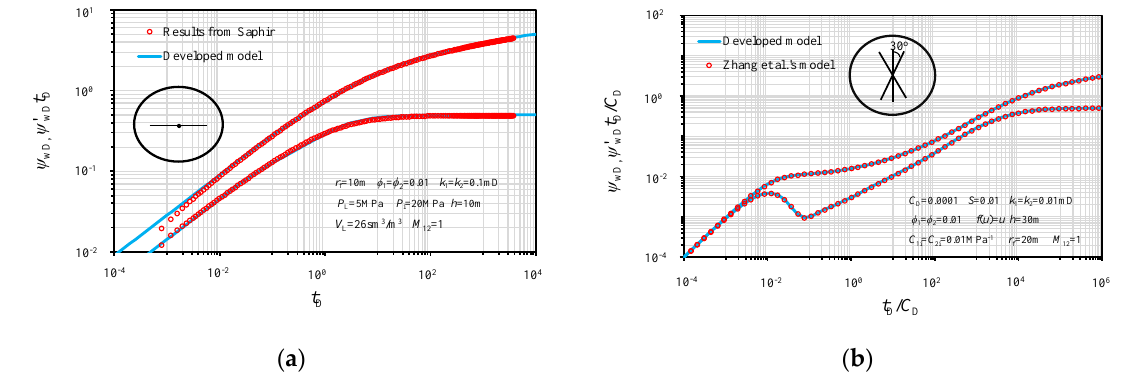
Figure 5. Comparison results between ( a ) the developed model and the model from Saphir and ( b ) the developed model and the model proposed by Zhang et al. [20].